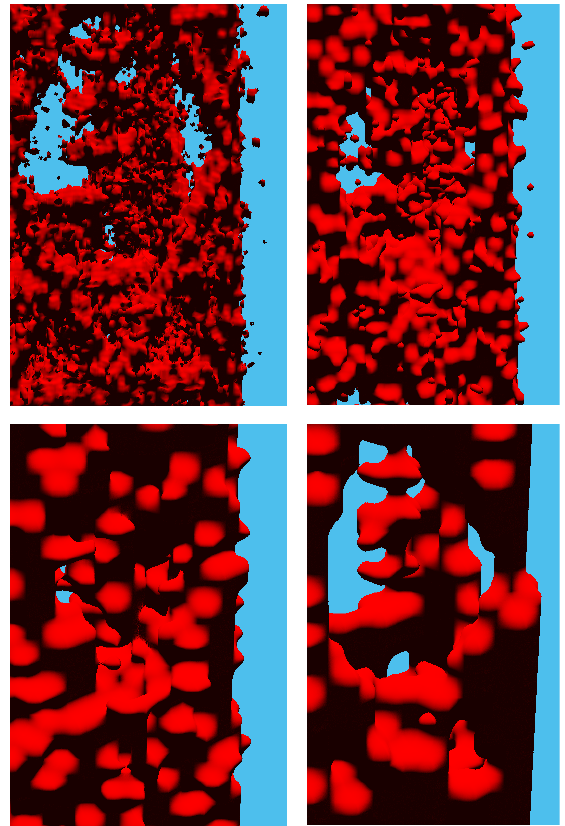
Figure 7. The voxel matrices at 5 cm, 10 cm, 15 cm, and 20 cm